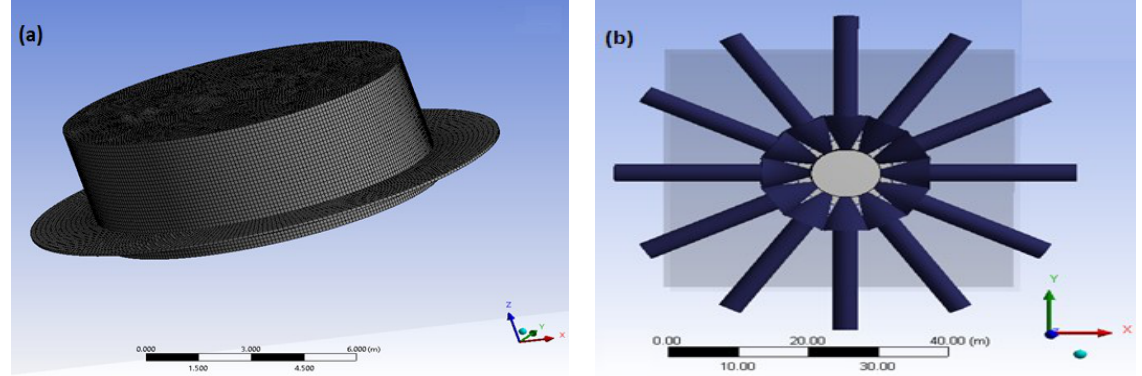
Figure 4. Buoy Design in ANSYS AQWA 2020 R2 showing ( a ) Hydrodynamic Panel, and ( b ) Wave Direction on buoy.